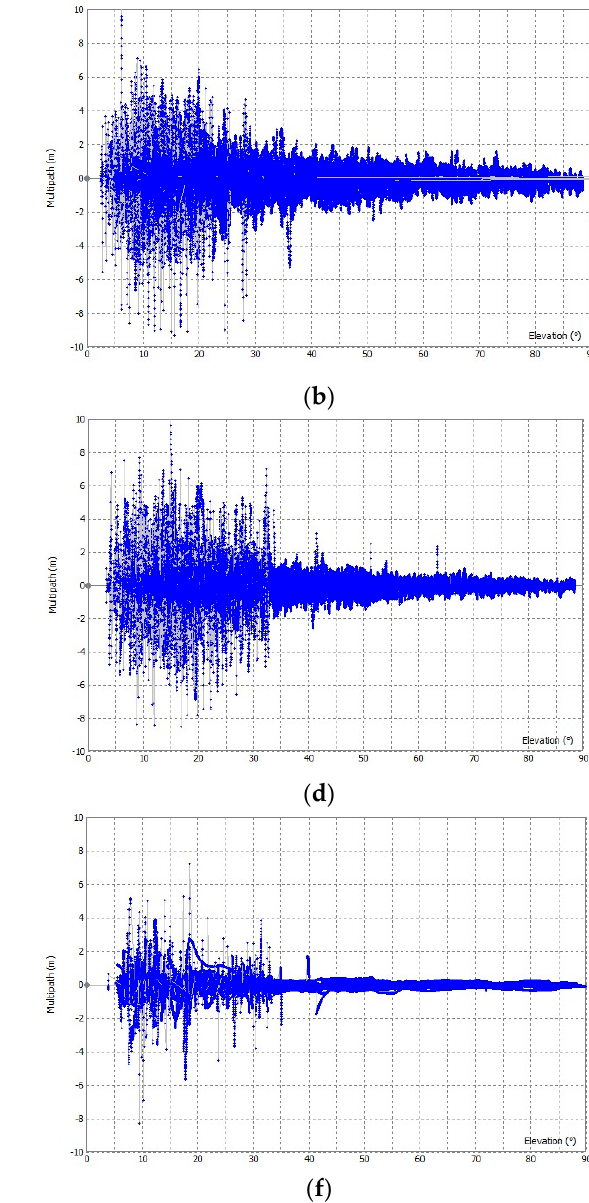
12 of 20 Table 2. RMSE for multipath error in open-sky and urban conditions.